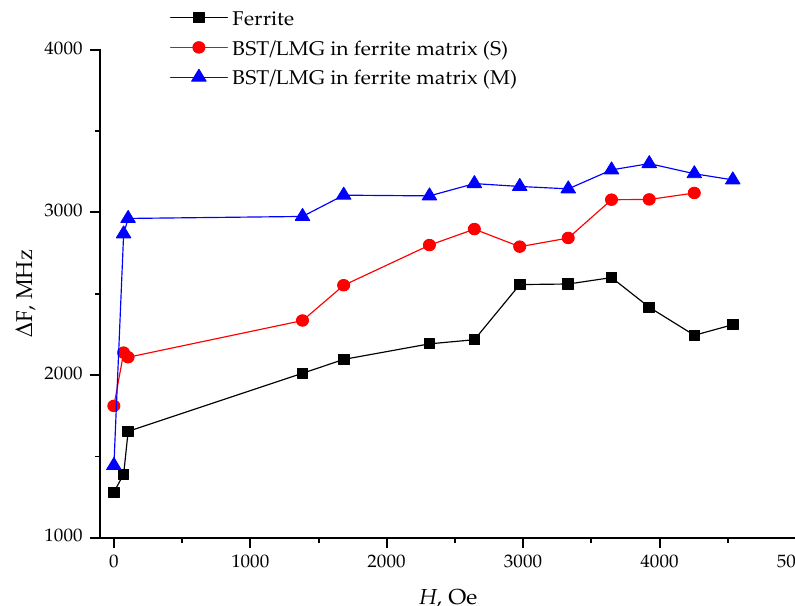
Figure 6. Width of the absorption spectrum of samples vs. magnetization field.